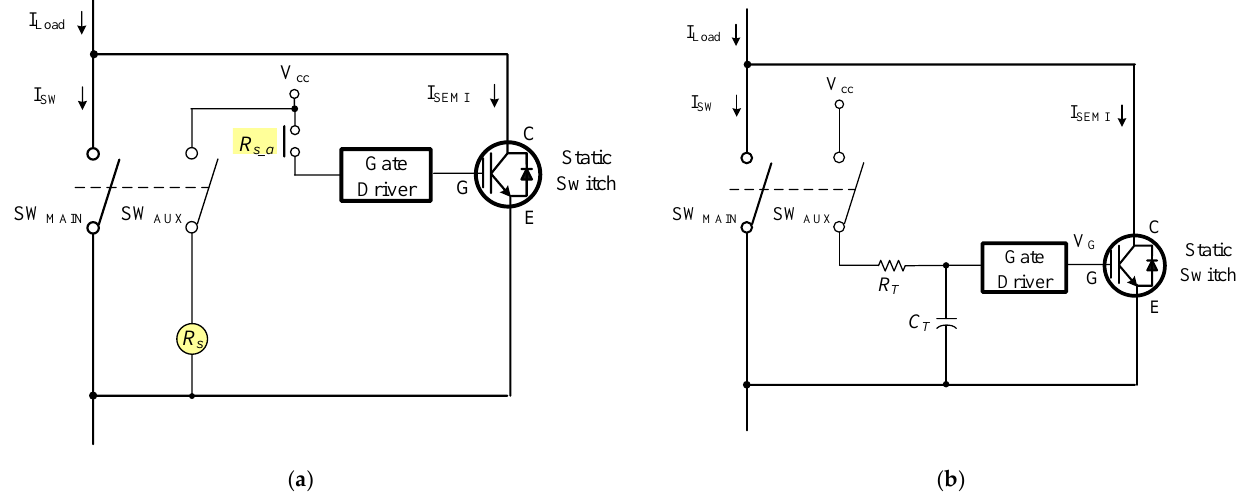
Figure 3. Concept of the proposed hybrid circuit breaker gate driving circuit; ( a ) Using timer relay, ( b ) Using R–C delay circuit.